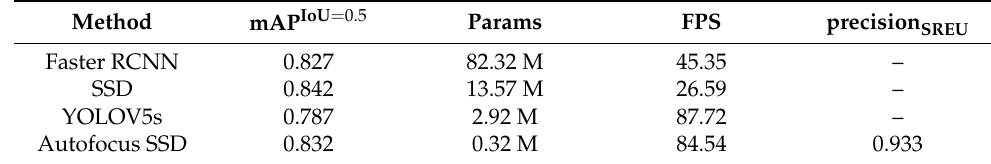
Figure 7. Detecting objects on ASTIL raw echo signals using Autofocus SSD. Table 4. Network performance